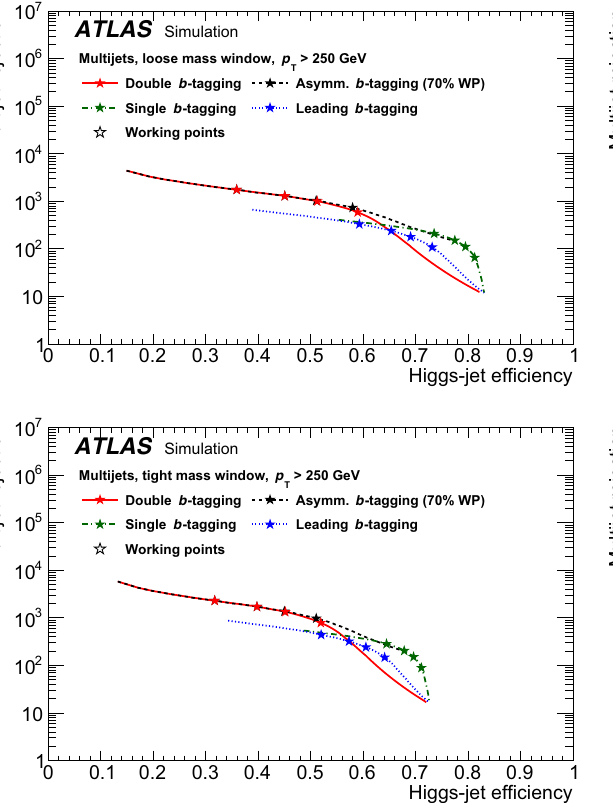
spond to the 60%, 70%, 77% and 85% b -tagging WPs (from left to right). The curves for the double- and asymmetric- b -tagging working